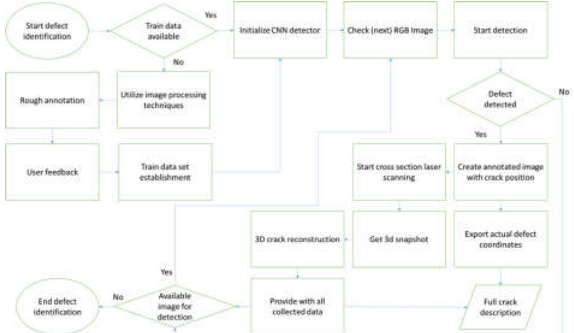
Figure 4. The defect identification approach based on RGB images and laser